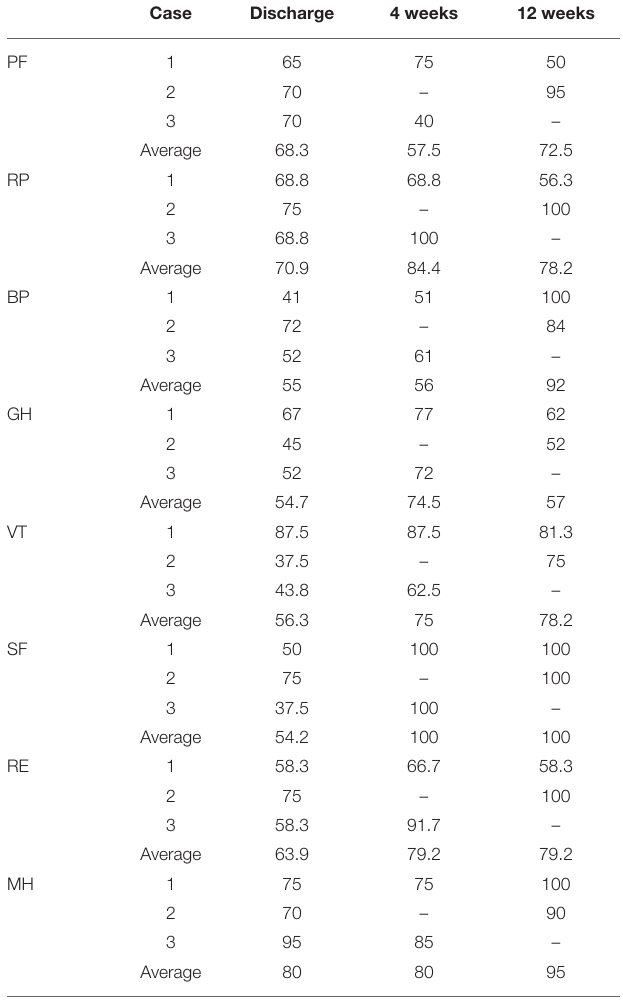
at 4 weeks after discharge. Corresponding SF-36 scores are shown in Table 1 : PF 70.0 and 40.0, RP 68.8 and 100.0,